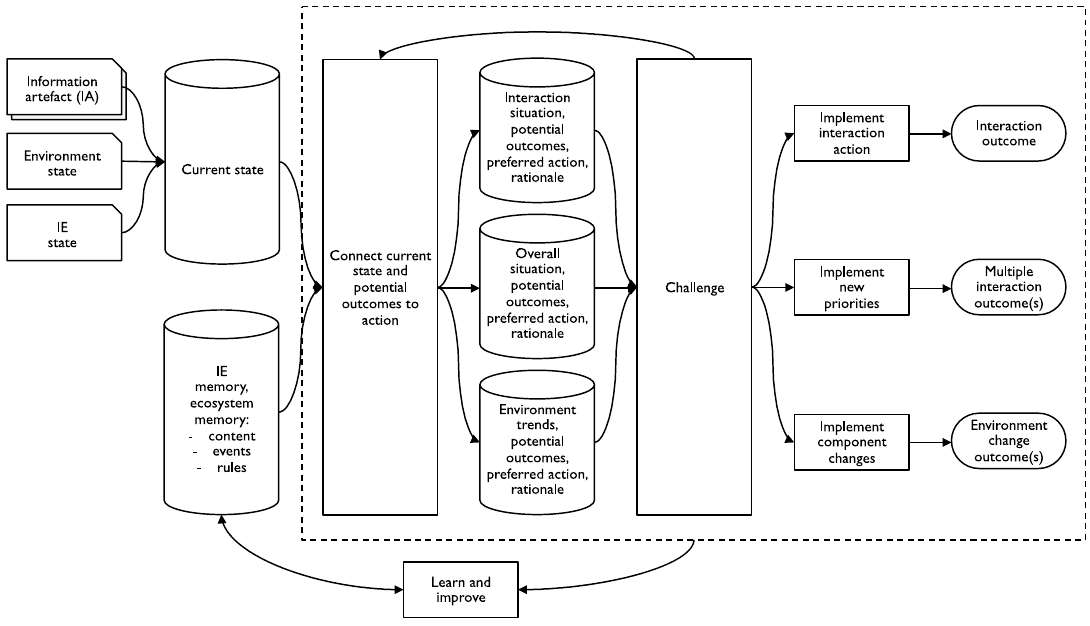
Figure 3. Information-aligned component pattern.